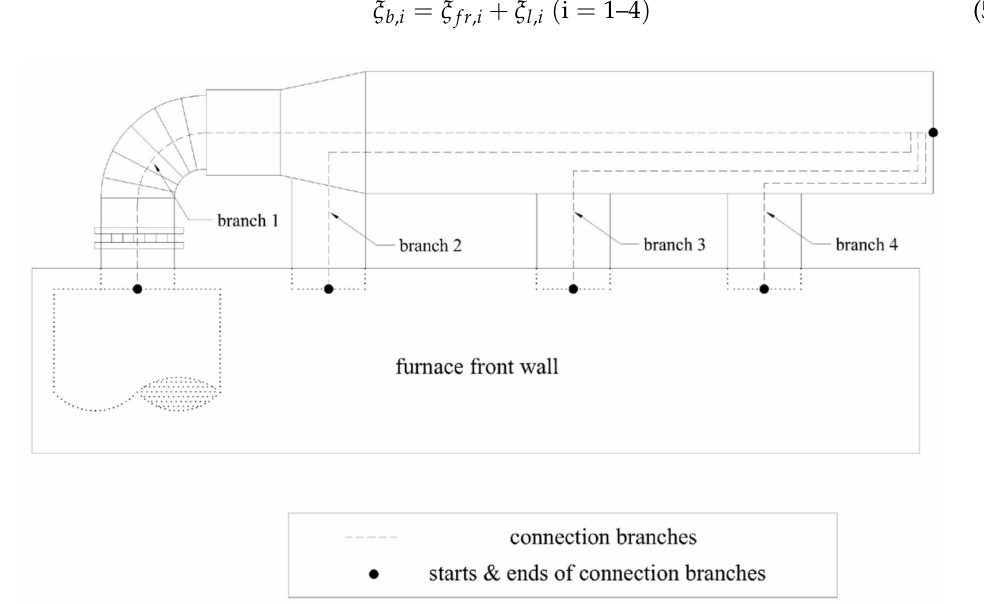
Figure 4. Structure of C-type connection mode (from the view of furnace front